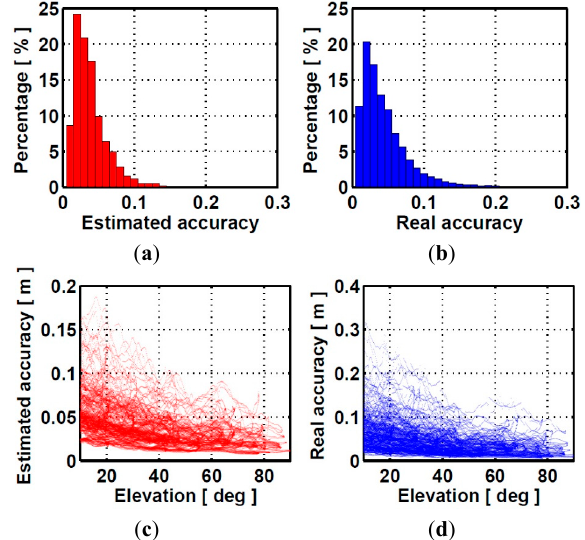
Figure 7. ( a ) distribution of peak-to-peak amplitudes of estimated accuracy of ionospheric correction; ( b ) distribution of peak-to-peak amplitudes of real accuracy of ionospheric correction; ( c ) peak-to-peak amplitudes of estimated accuracy of interpolated ionospheric corrections against elevation function; ( d ) peak-to-peak amplitudes of real accuracy of interpolated ionospheric corrections against elevation function.